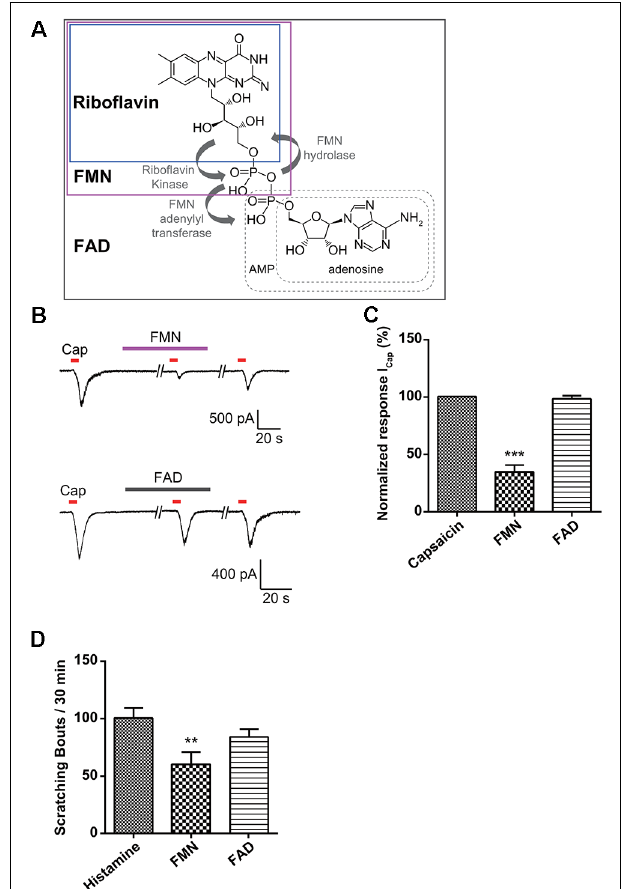
FIGURE 4 | Effect of flavin mononucleotide (FMN) and flavin adenine dinucleotide (FAD) on capsaicin-induced currents in small-sized dorsal root ganglion (DRG) neurons. (A) Biosynthesis of FMN and FAD from riboflavin. (B) A representative trace of capsaicin (Cap, 200 nM)-induced inward current in the absence and presence of FMN (1 µ M) or FAD (1 µ M) are shown. (C) The relative peak amplitudes of capsaicin-induced inward currents after a second stimulation compared to those after the first stimulation of each neuron are shown (holding voltage at − 60 mV), normalized to the current in the same cell (*** p < 0.001, n = 8, LSD’s post hoc after one-way ANOVA). (D) The total scratching bouts during the first 30 min after the intradermal injection of FMN (1 µ M) and FAD (1 µ M) compared to those with histamine (100 µ g/50 µ l). Results are presented as the mean ± SEM (** p < 0.01, n = 4, LSD’s post